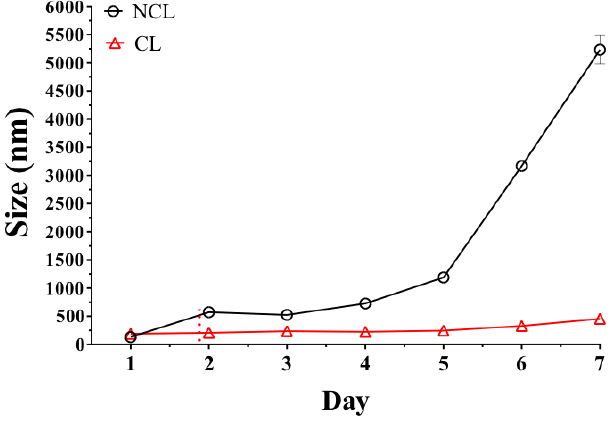
Figure 6. Evaluation of liposomal size change with time. 230